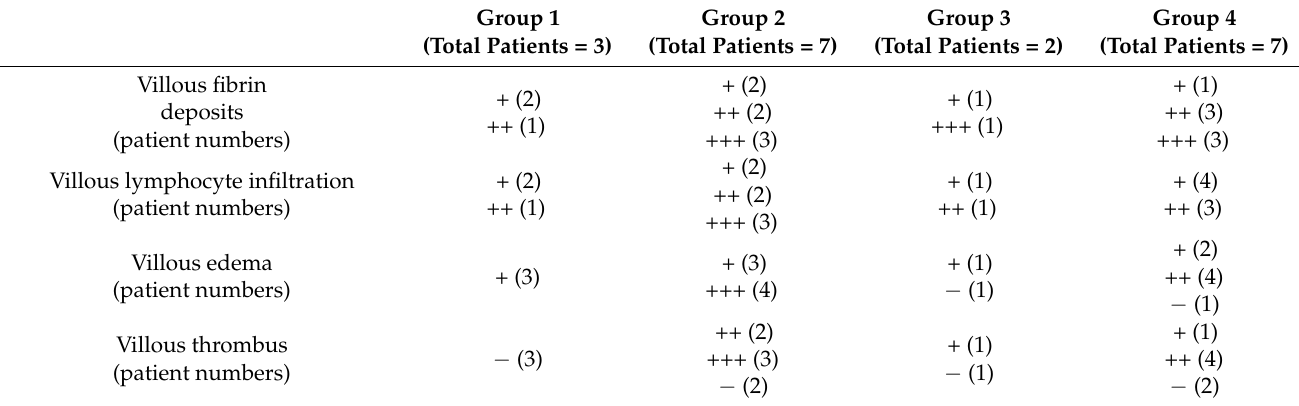
Table 2. Histopathological